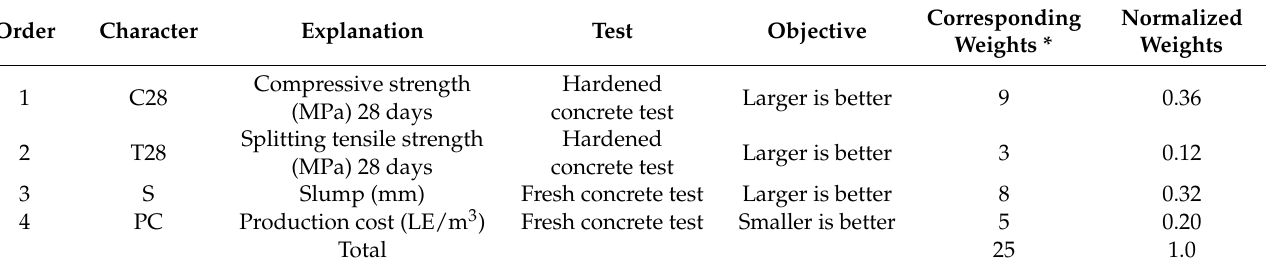
Table 4. The weights of each parameter for the TOPSIS method.